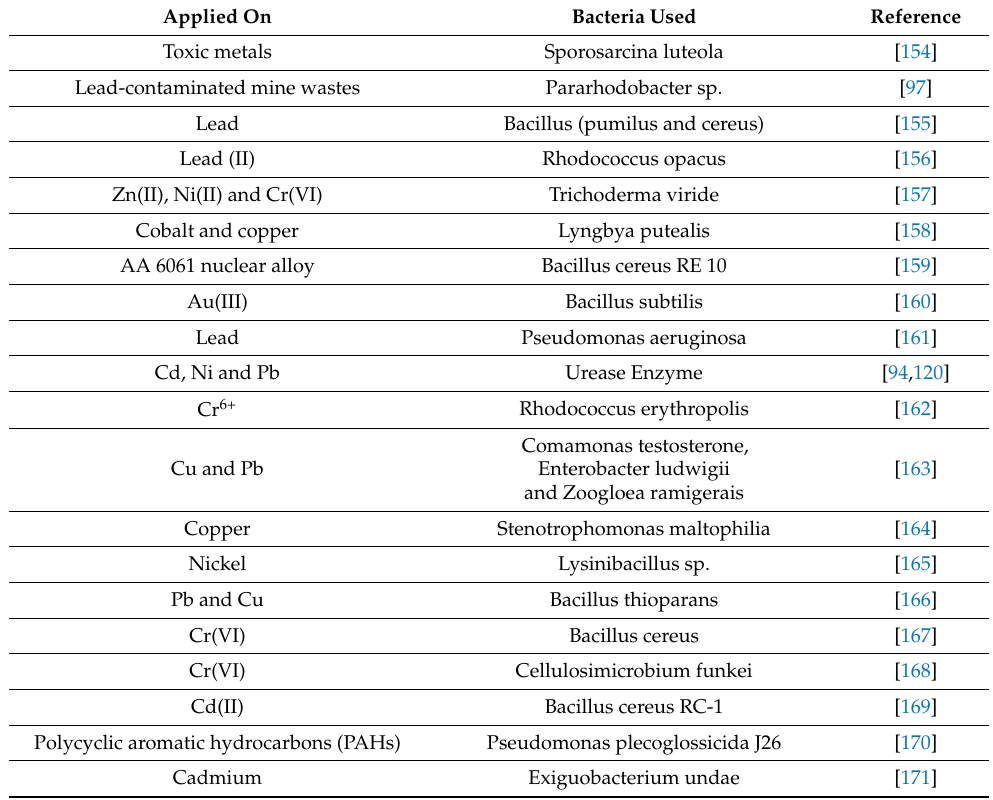
Table 2. List of contaminants remediated by the biostabilization method. Applied